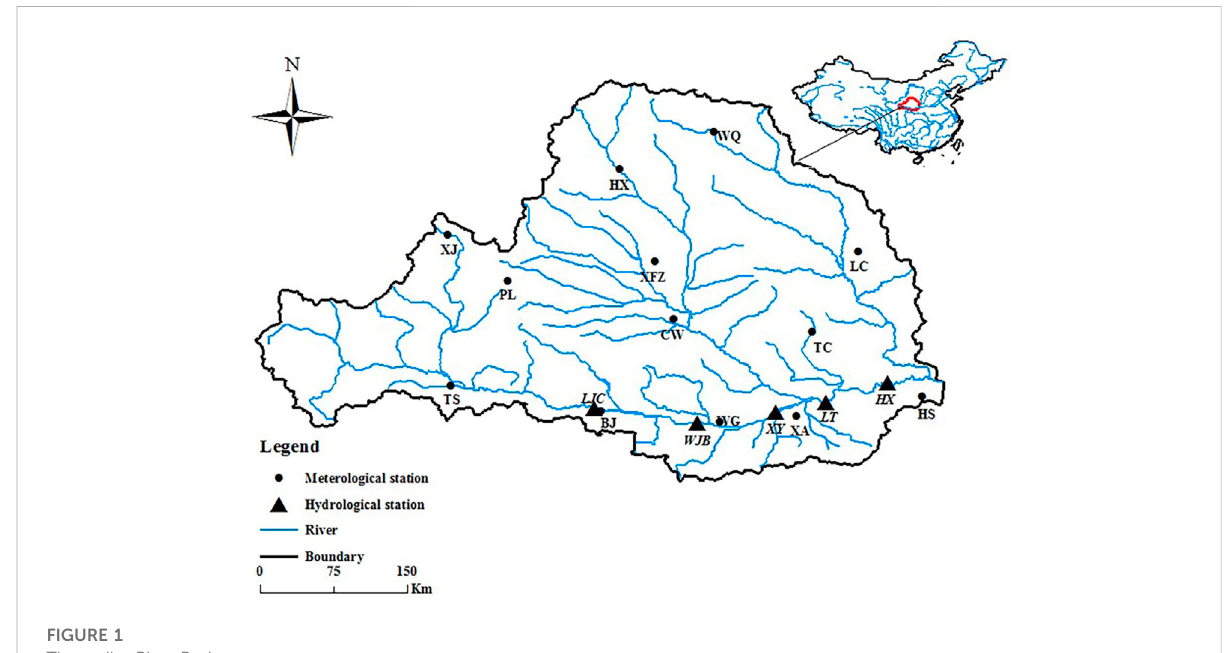
FIGURE 1 The weihe River Basin